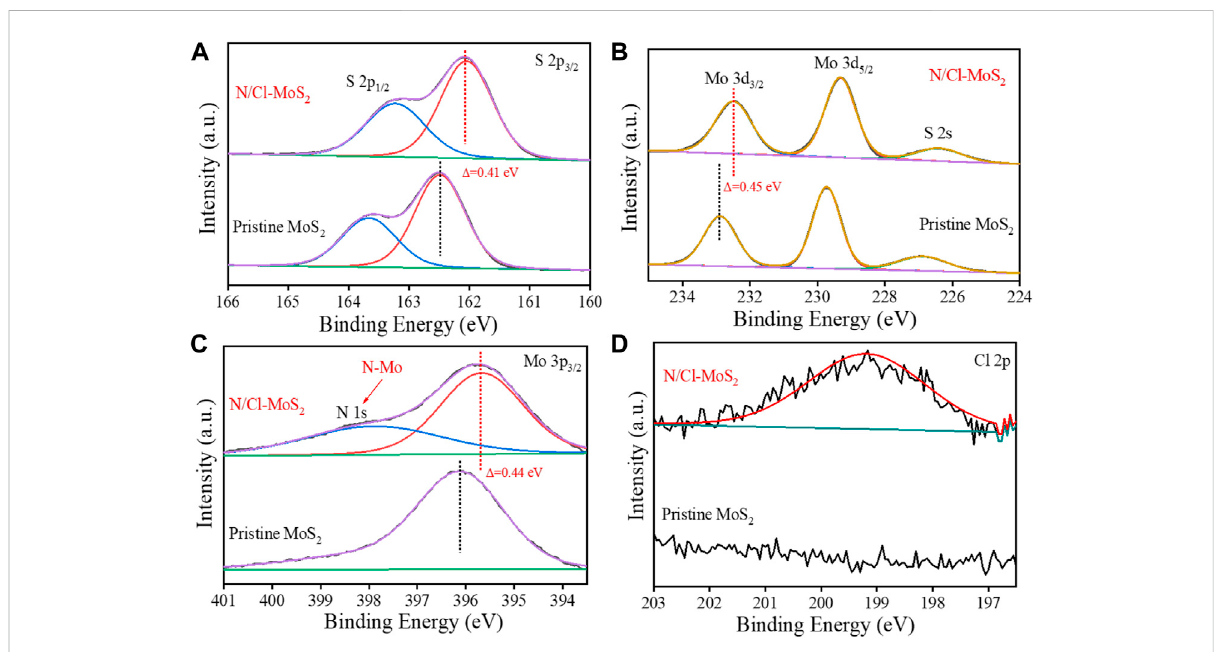
FIGURE 3 XPS spectra of the pristine MoS 2 and N/Cl-MoS 2 . (A) XPS spectra of S 2p in MoS 2 samples. (B) XPS spectra of Mo 3 d in MoS 2 samples. (C) XPS spectra of Mo 3p and N 1s in MoS 2 samples. (D) XPS spectra of Cl 2p in the MoS 2